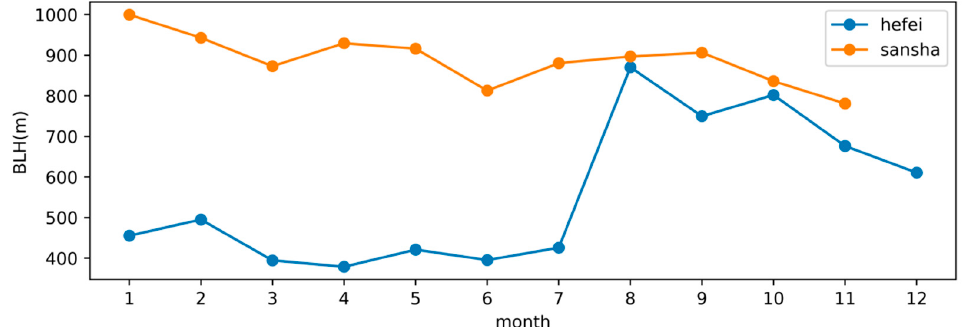
Figure 1. Monthly average of boundary layer height in Sansha and Hefei. The absence of data in December in Sansha is due to the lack of lidar data.